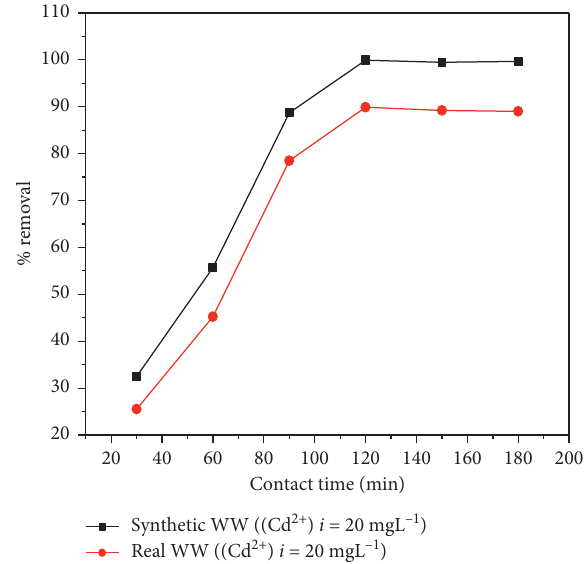
Figure 8: The effects of wastewater chemistry for both synthetic and real wastewater on the percent removal of Cd(II) ions at 20mg/ L and 20 ° C by using MA-CNC